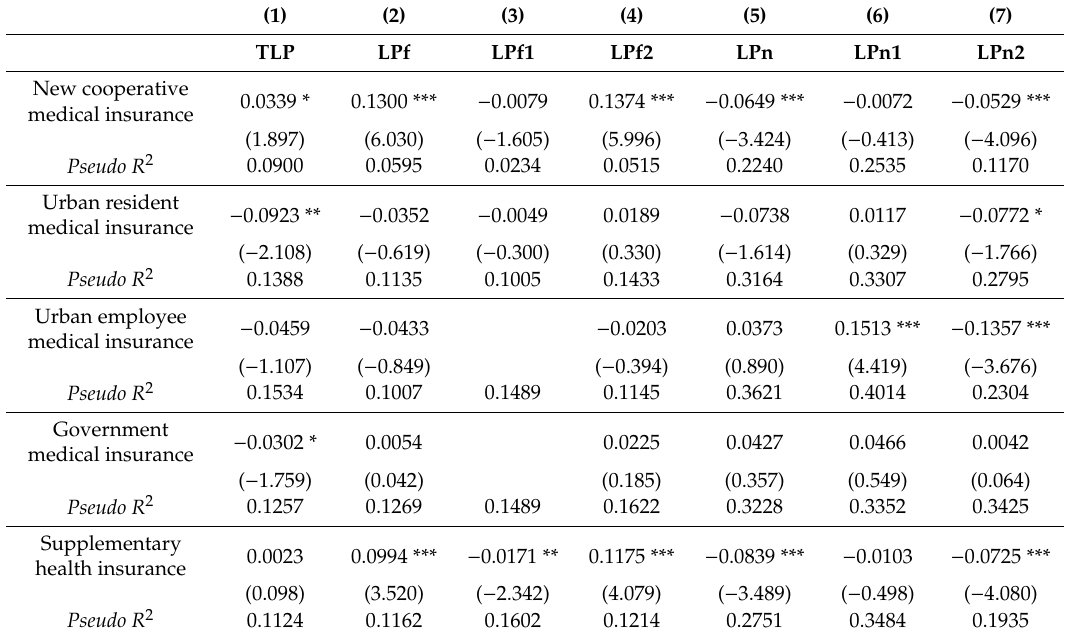
Table 10. Model estimation of labor participation in di ff erent types of health